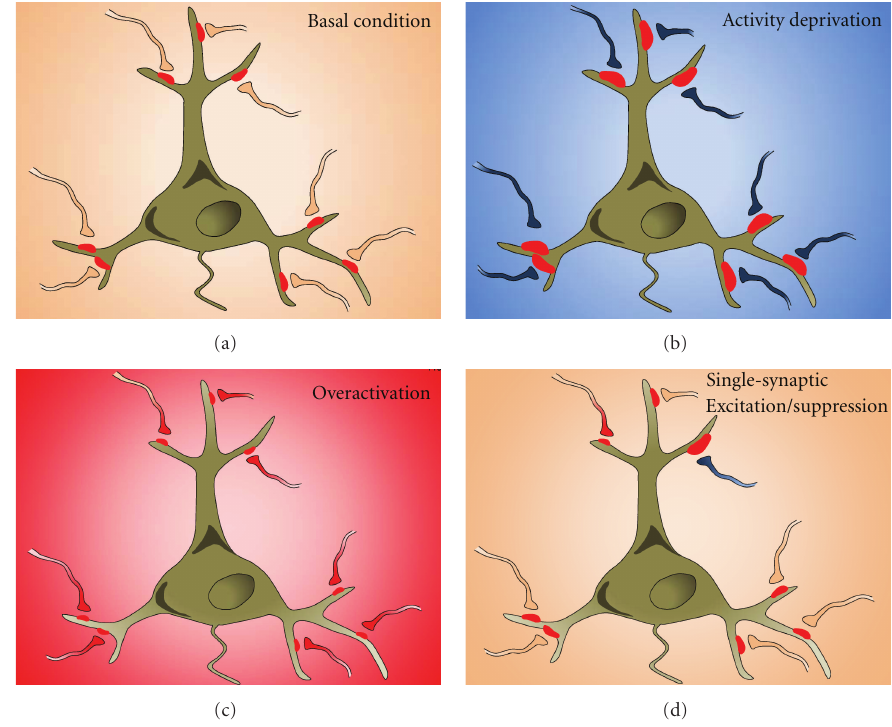
Figure 1: Global and local homeostatic synaptic plasticity. Under basal condition, neurons have a relative stable level of activity as a result of basal synaptic inputs mediated by AMPARs (red clusters) at the postsynaptic domains (a). When the activity of a neuron or a network is chronically suppressed such as by TTX incubation, the strength of all synapses is elevated proportionally via an increase in AMPAR abundance (b). In contrast, an overall reduction in synaptic AMPAR accumulation is induced by lasting overactivation of neuronal activity (c). At individual synapses, long-term synaptic inactivity (terminal in blue) leads to a homeostatic increase in AMPAR amount, whereas lasting synaptic excitation causes selective AMPAR reduction at the stimulated synapse (terminal in red), without a ff ecting the neighboring normal synapses